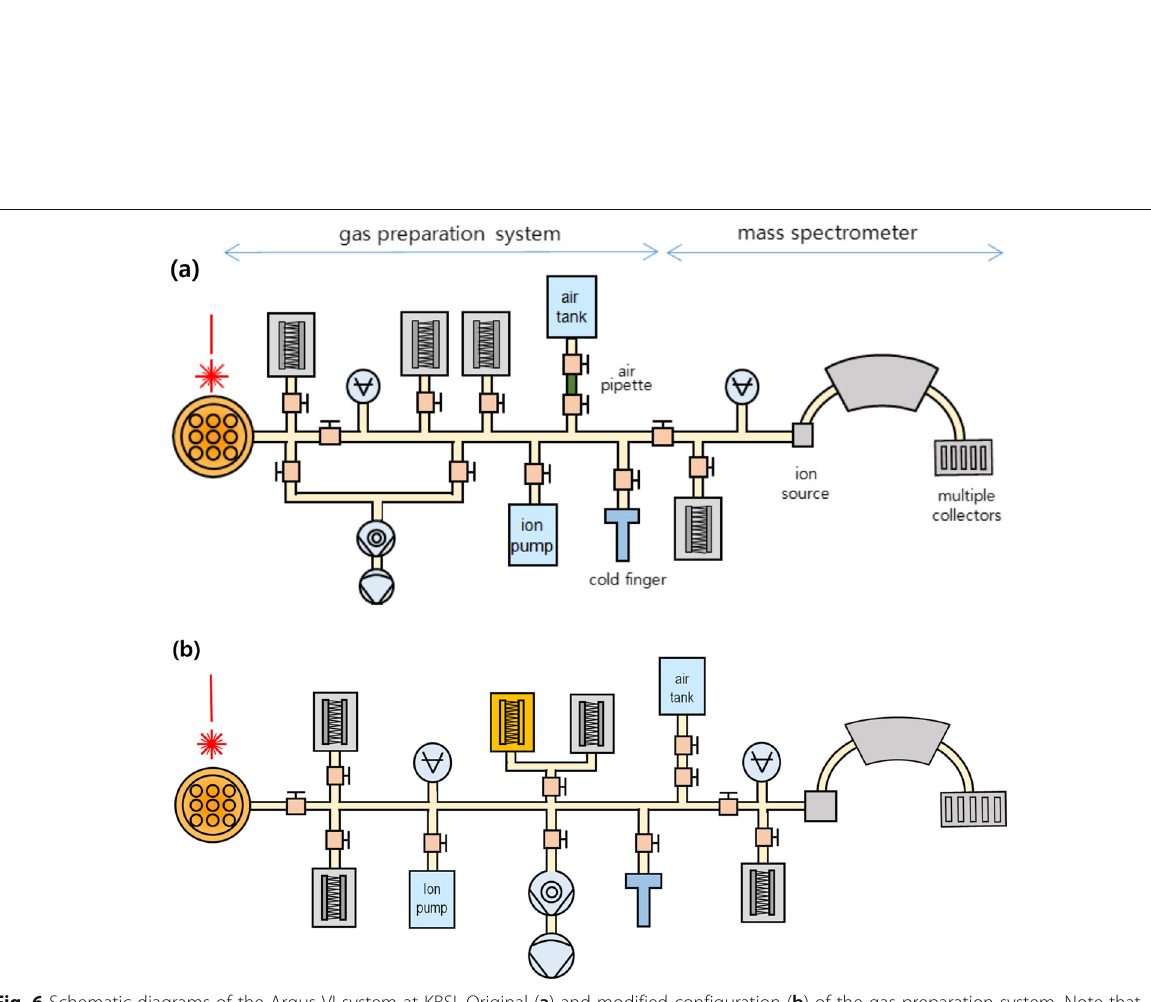
Fig. 6 Schematic diagrams of the Argus VI system at KBSI. Original ( a ) and modified configuration ( b ) of the gas preparation system. Note that one of the getters operates in hot